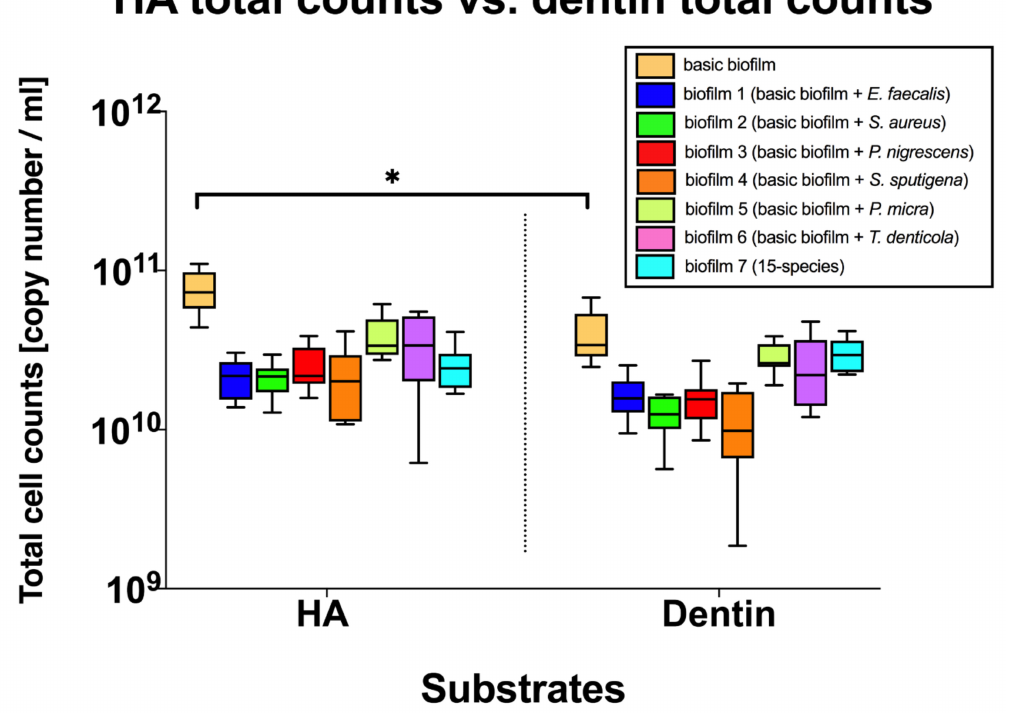
Figure 4. Boxplots demonstrating total cell counts per endodontic-like biofilm on HA and dentin discs after analysis by qPCR. To form endodontic-like multispecies biofilms, a total of six bacterial species were added separately to a “basic” nine-species subgingival biofilm. The x -axis shows endodontic-like biofilms on HA and dentin discs. Statistically significant di ff erences between the total counts of the two substrates is marked with 1–4 asterisks (* p < 0.05). The internal line represents the median; whiskers indicate minimum and maximum. The p values ( p ≤ 0.05) of the significantly di ff erent data are provided. The data were derived from three independent experiments, each represented in triplicate biofilm cultures ( n =